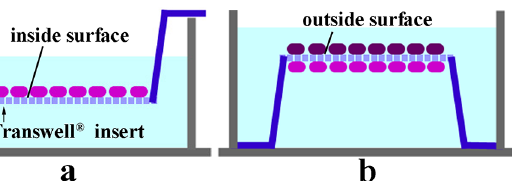
Fig 1. Transwell culture system. BRL 3A cells were cultured on the inside surfaces of Transwell cell culture inserts in serum-free DMEM with 10 μ M Cd for 12 h (a). The inserts were then overturned and BRL 3A cells seeded on the outside surface of the inserts(b), with both sides then incubated in culture medium with 50 μ M Sal, 5 μ M GA, 10 μ M U0126, 10 μ M SP600125 or 10 μ M SB202190 for 36 h.